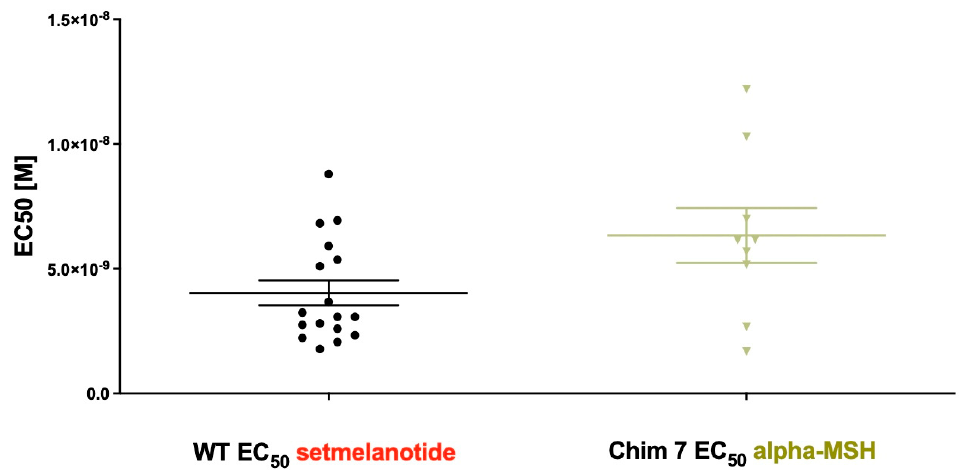
Figure 6. EC 50 of G q/11 signaling of MC4R-WT stimulated with setmelanotide compared to EC 50 of Chim 7 stimulated with alpha-MSH . Concentration–response curves were used to determine potency. EC 50 of MC4R-WT after setmelanotide stimulation (4.04 ± 0.5 nM) appeared similar to EC 50 of Chim 7 after alpha-MSH stimulation (6.33 ± 1.1nM). Data are given as the result of 9 to 17 independent experiments performed in triplicate. Values represent mean ± SEM.